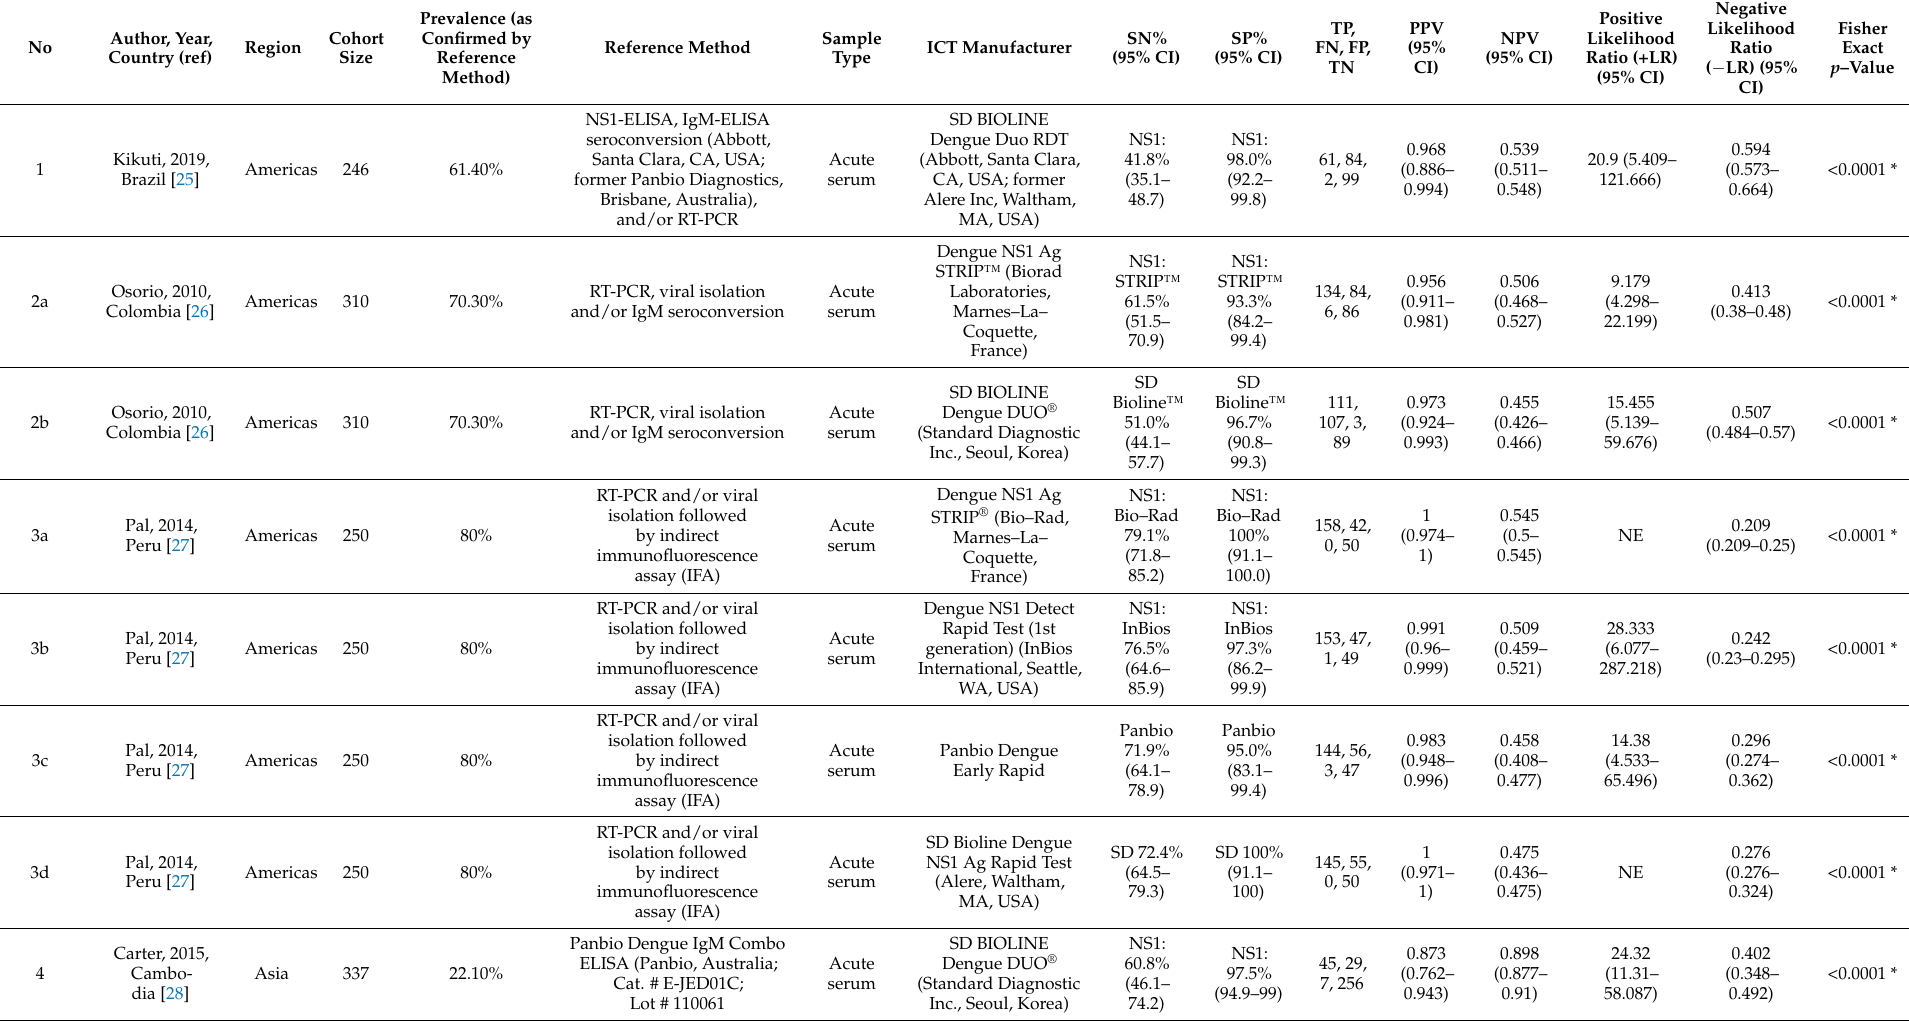
Table 3. NS1 (Only) summary findings of post-hoc